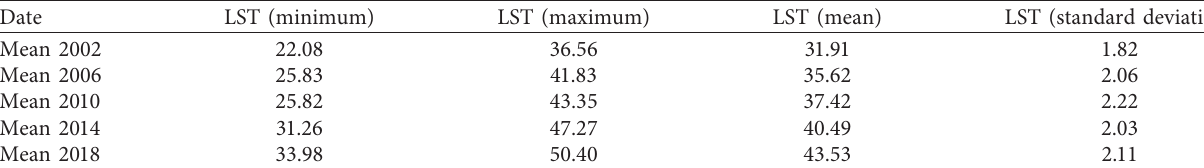
Table 3: Temporal variations in the distribution of LST (oC) (2002–2018).